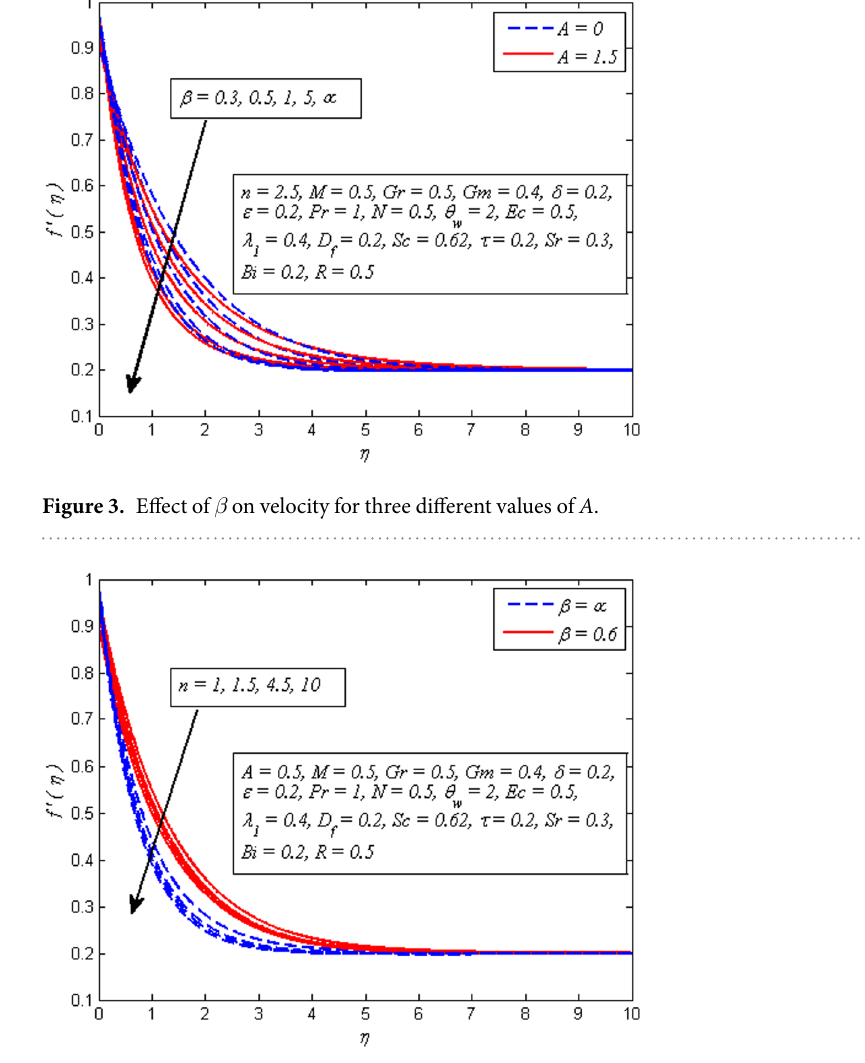
Figure 4. Effect of n on velocity for two different values of β .